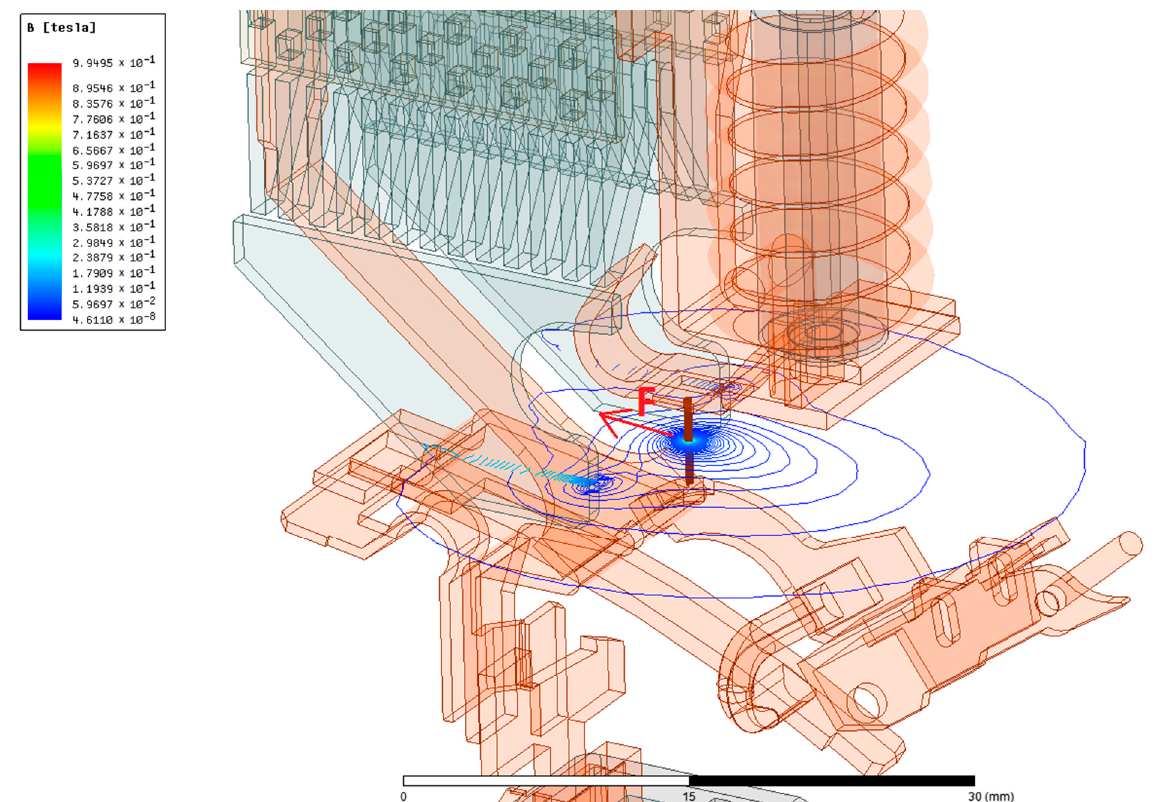
Figure 11. Distribution of the arc electromagnetic induction lines and the return of the electrodynamic force acting on the arc pushing it between the side ferromagnetic plates.